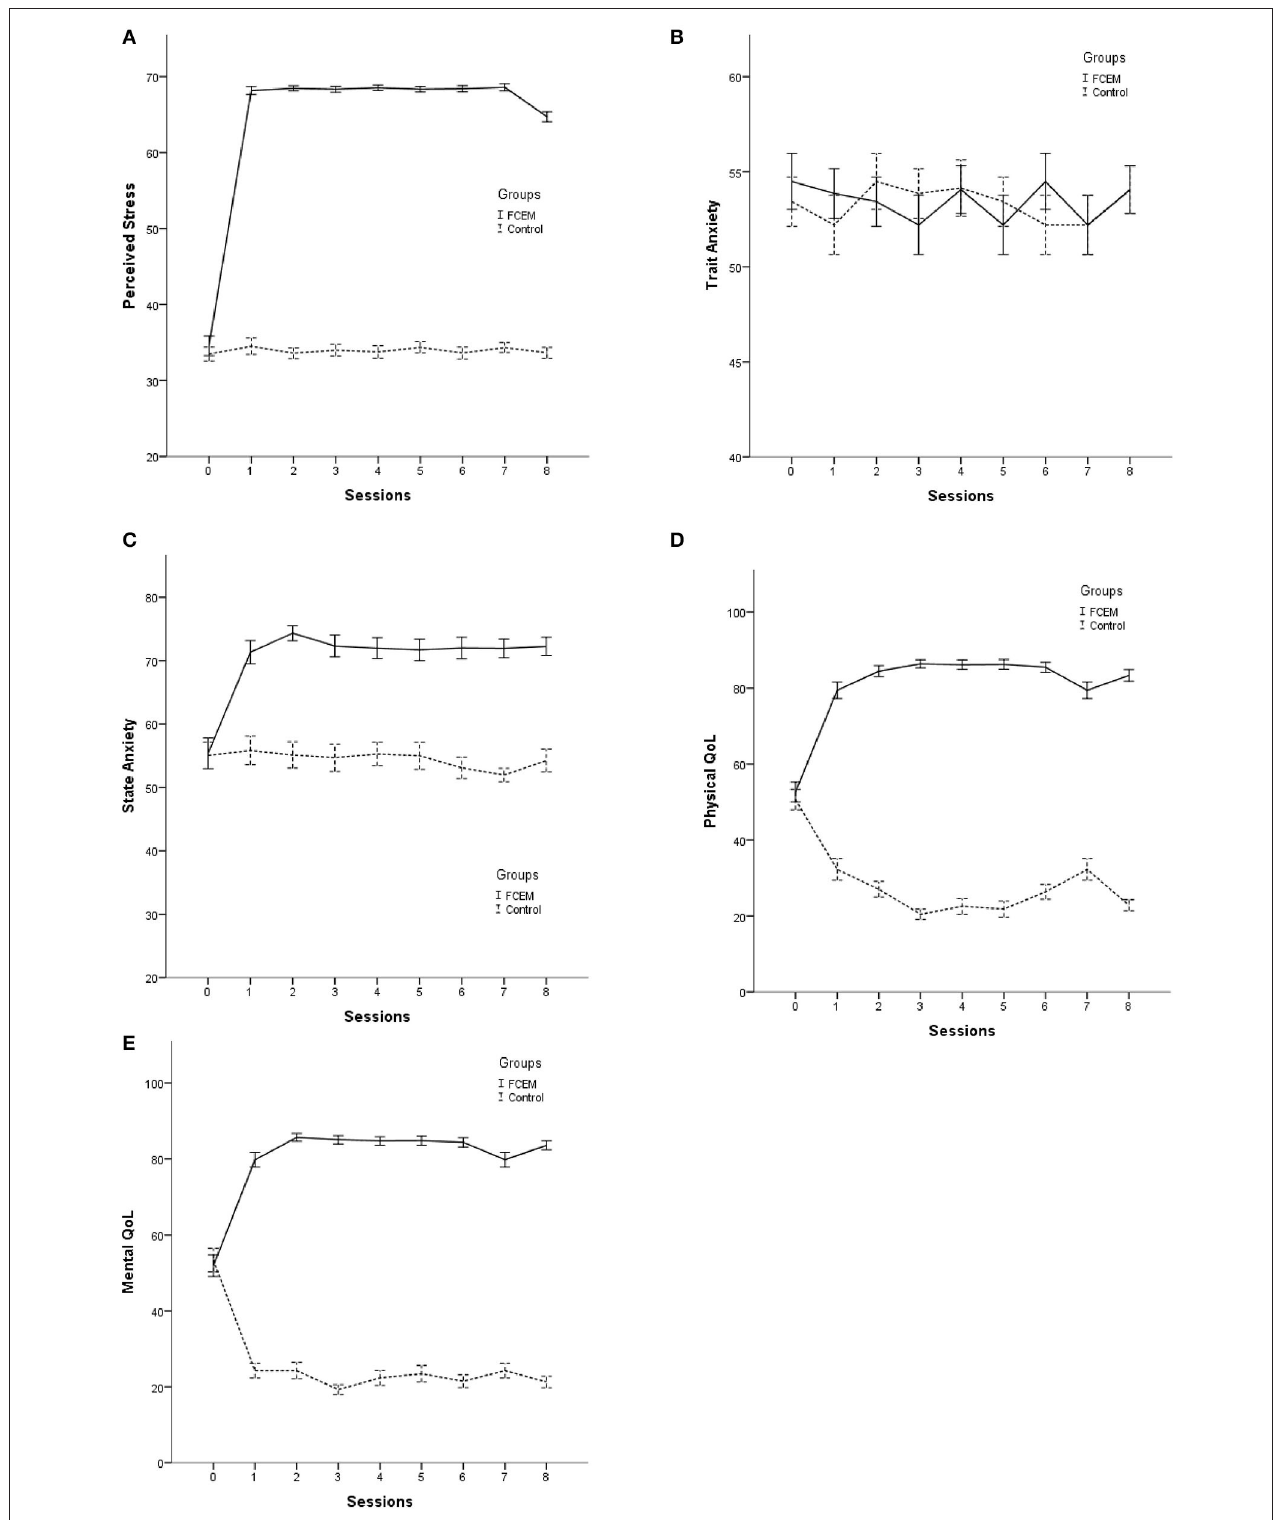
FIGURE 1 | The trend of study outcomes across the follow-up sessions according to the study groups. (A) Perceived stress assessment; (B) Trait anxiety assessment; (C) State anxiety assessment; (D) Physical dimension of quality of life; and (E) Mental dimension of quality of life.